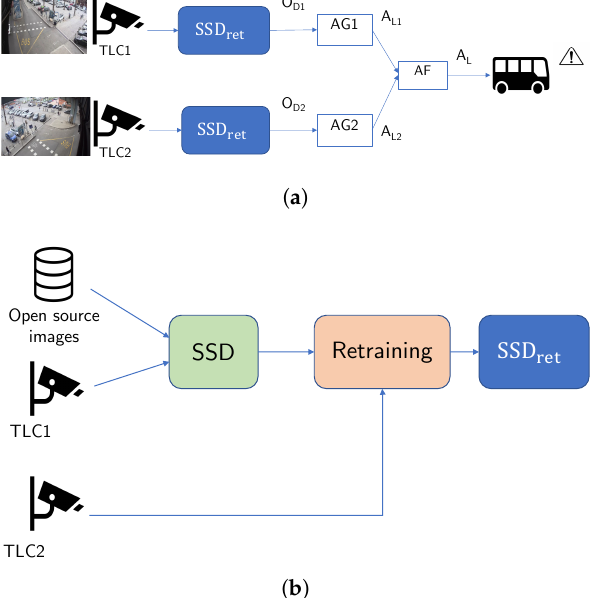
Figure 1. Flowchart of the procedures exploited for the proposed VCA system, sketching the alert generation and fusion ( a ) based on model SSD ret , obtained via a retraining process ( b ). ( a ) Inference. ( b )